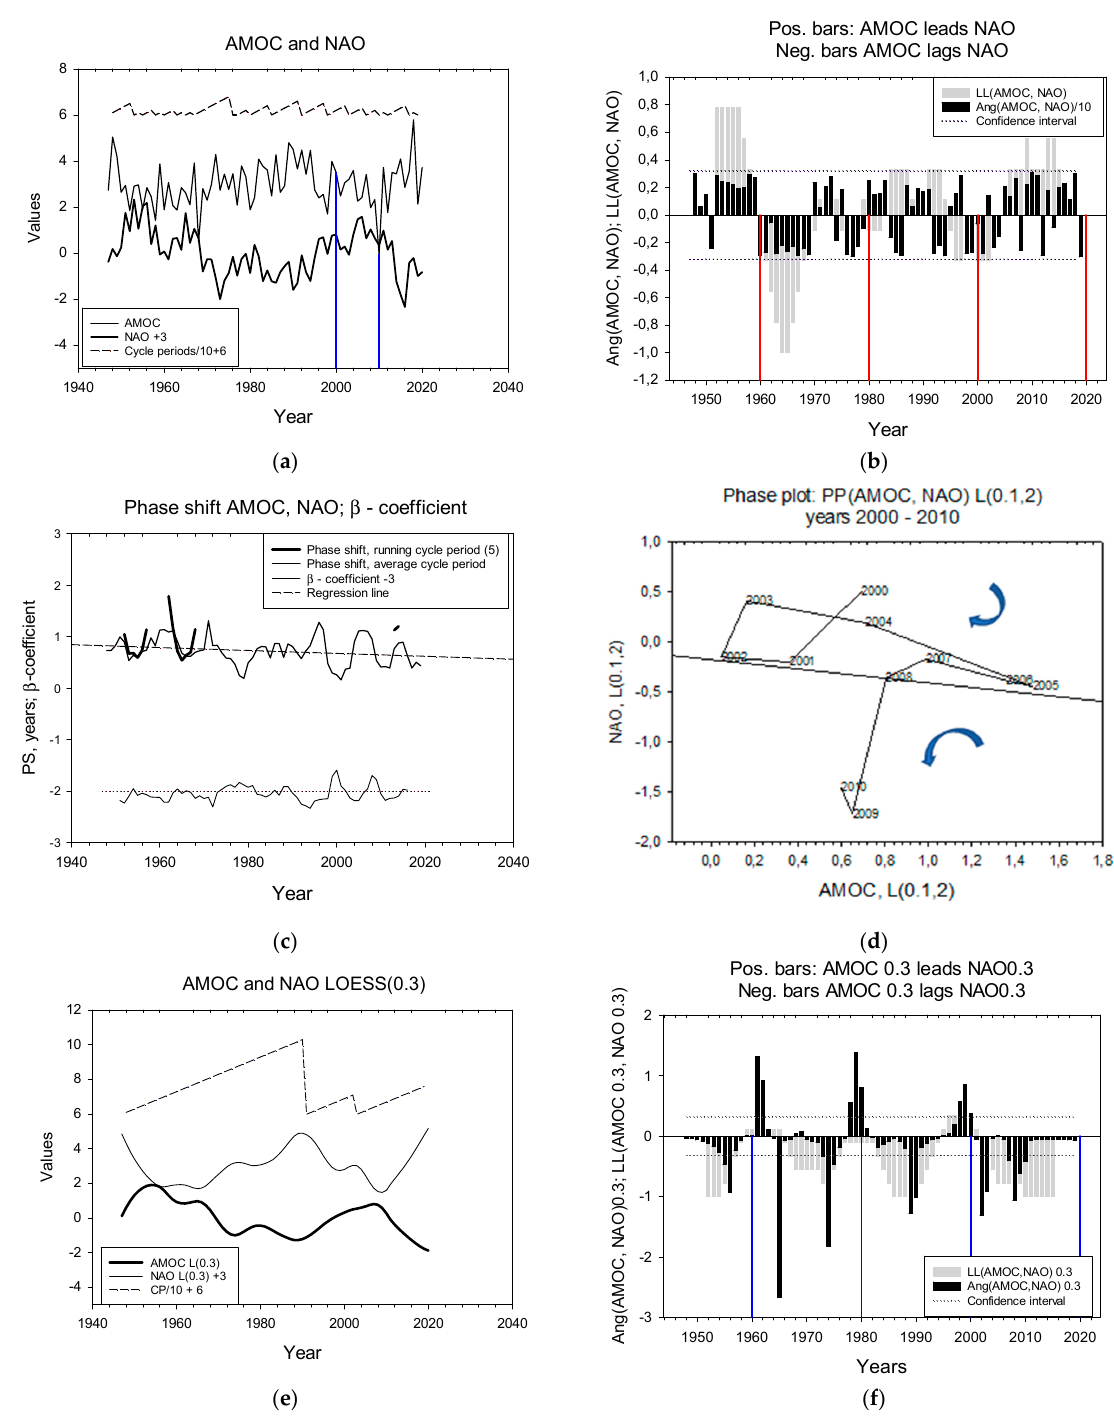
Figure 4. LL relations for AMOC and NAO. ( a ) Time series raw. The upper zigzag curve shows cycle periods. ( b ) LL relations between AMOC and NAO. Black bars show angles, θ (3), calculated over three consecutive observations; grey bars show the sign of angles, LL(9) calculated over 9 years. Dashed lines show confidence interval. Droplines designate time windows of 20 years starting at 1960. ( c ) Phase shift calculated with two methods (Thin line: average cycle period; bold line: running average cycle period) and the β -coefficient for the two series. ( d ) Phase plot for the two series with AMOC and NAO slightly LOESS(0.1)-smoothed on the x- and y-axis, respectively. ( e ) The two series LOESS(0.3)-smoothed and their cycle periods. ( f ) LL relations between the two series. Black bars for θ (3), and grey bars for